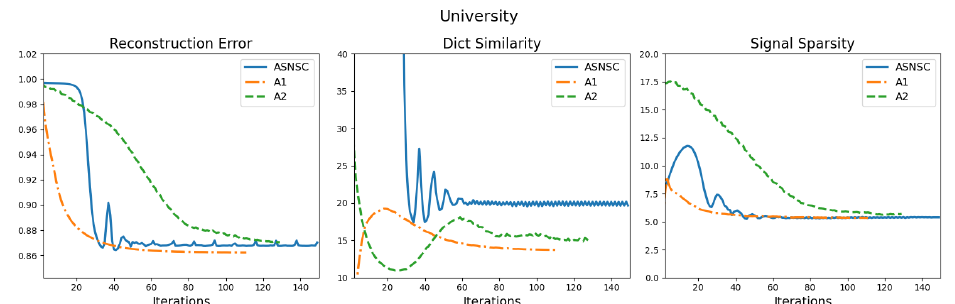
Figure 4. Convergence graphs for the three metrics, for all algorithms and datasets. The reconstruction error, dictionary similarity (coherence), and signal sparsity metrics are computed using (14), (15) and (16), respectively. (For interpretation of the line colors, the reader is referred to the web version of this article).